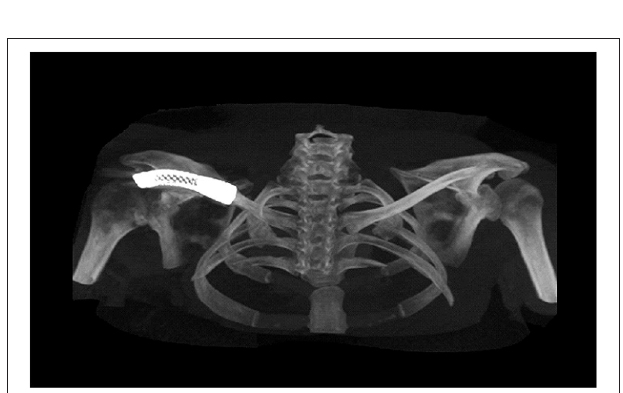
FIGURE 6 | Postoperative computed tomography scan 6 months after the operation revealed a good position for the prosthesis and no evidence of a stress